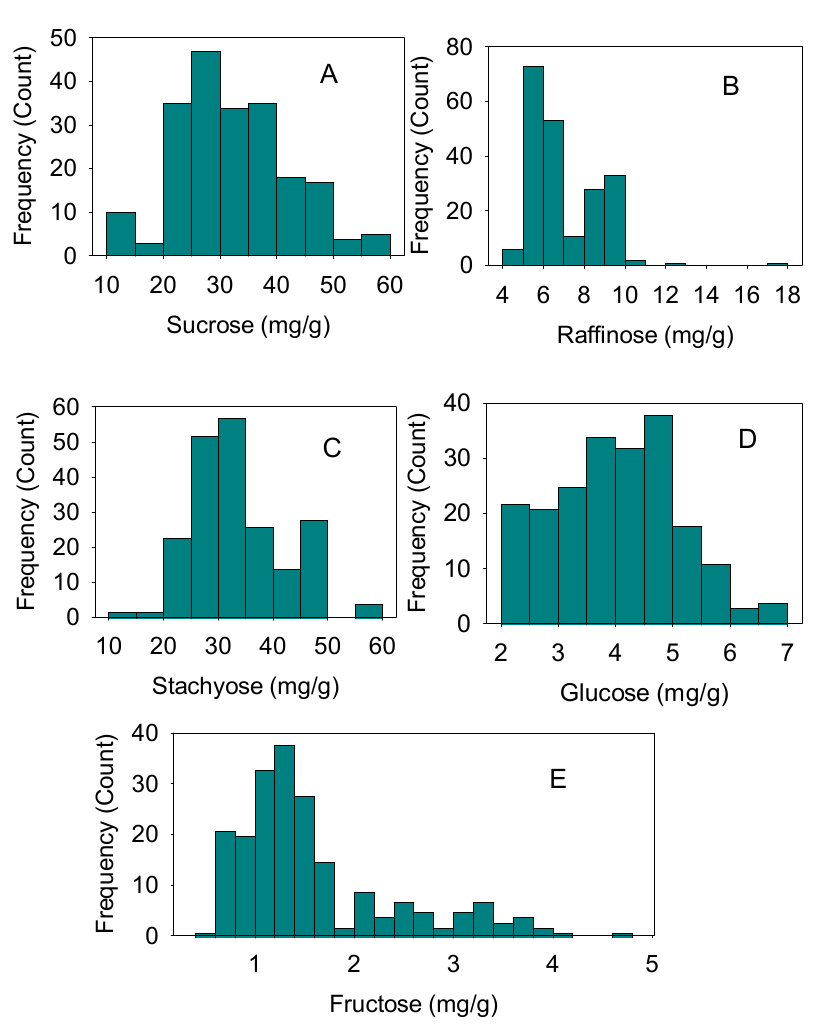
Figure 3. Distribution of soybean sugars (mg/g) across years, irrigation treatments, and genotypes. Sucrose, ( A ); raffinose, ( B ); stachyose, ( C ); glucose, ( D ); and fructose, ( E ). The experiment was conducted in 2012 and 2013 in Jackson, TN, USA. Gaps in x -axis in any distribution indicate there are no genotypes in that range. Frequency ( y -axis) refers to the number of individual replicates of genotypes. Moderately resistant genotypes were seven: DS-880, DT97-4290, Dyna-Gro 36C44, Osage, R07-7232, USG 75Z38, USG Allen; and susceptible genotypes were six: LS98-0358; Pharaoh; Progeny 4408; R01-581F; R02-1325; Trisoy 4788; two years were used; four replicates for each genotype were used.